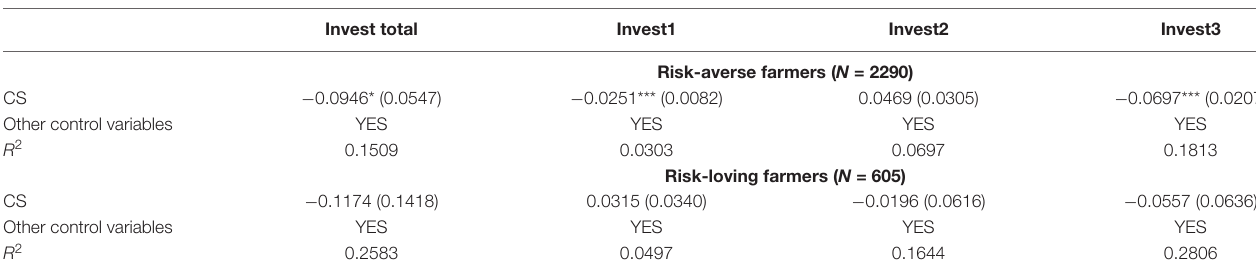
TABLE 9 | Climate shocks and farmers’ productive investment: Heterogeneity of risk